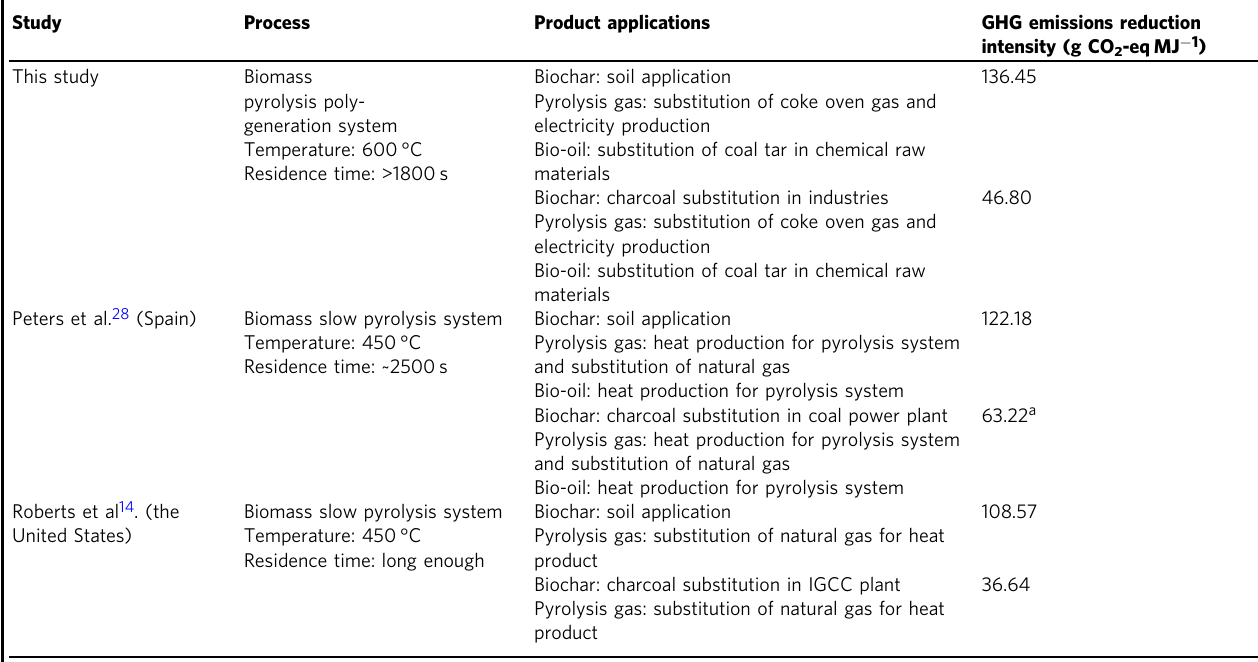
Table 1 Comparison of GHG emissions reduction (including fossil fuel offset) for pyrolysis systems with sequestration or use of biochar as fuel and use of other biofuels and